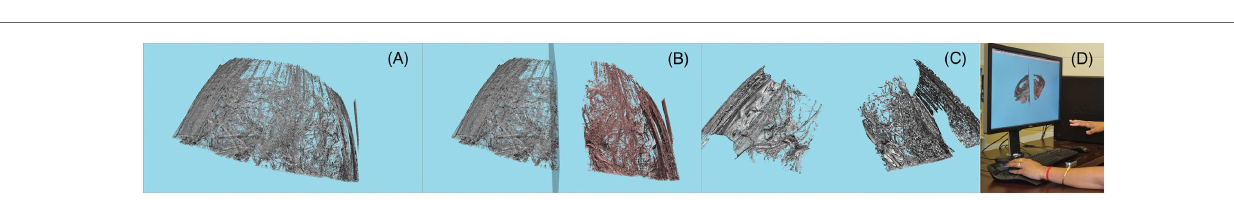
FigUre 2 | Bare-hand volume cracker (BhVc): a 3D interaction technique – (a) μ -cT scan of a beetle, (B) cracking preview, (c) cracked beetle, and (D) a participant using BhVc .